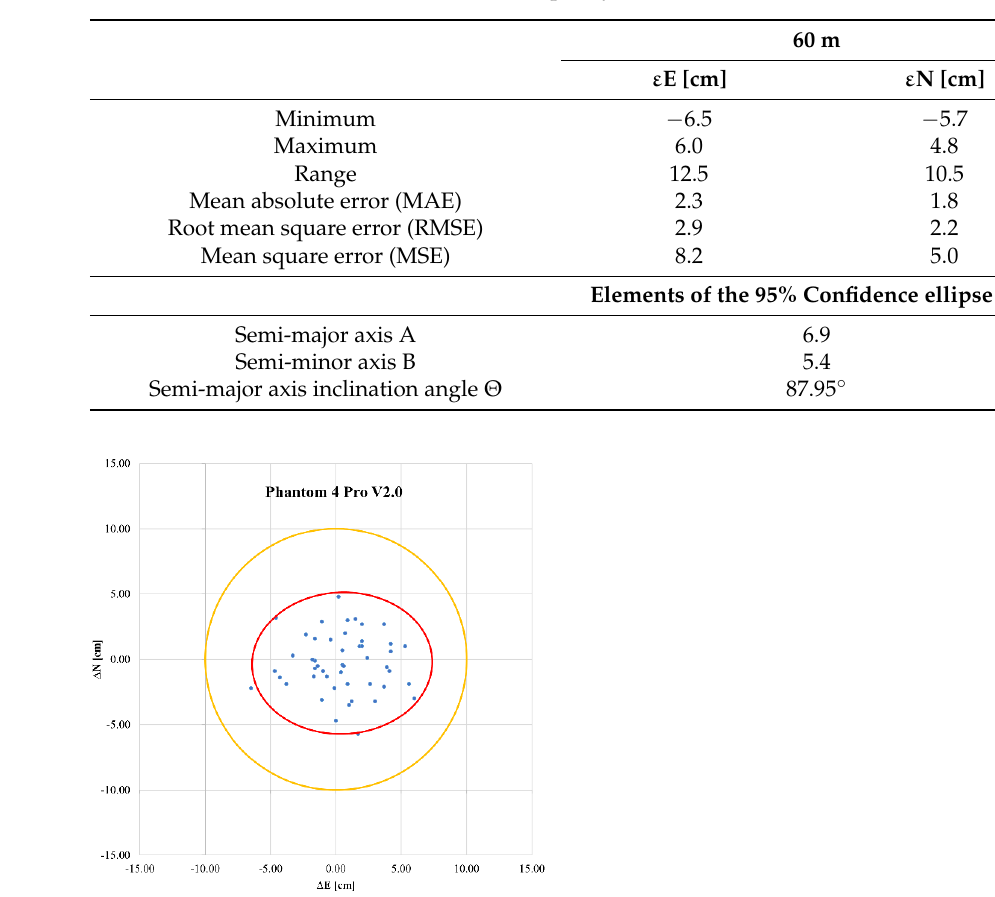
Figure 12. Confidence ellipse — Phantom 4 Pro V2.0 with GCPs at 60 m.